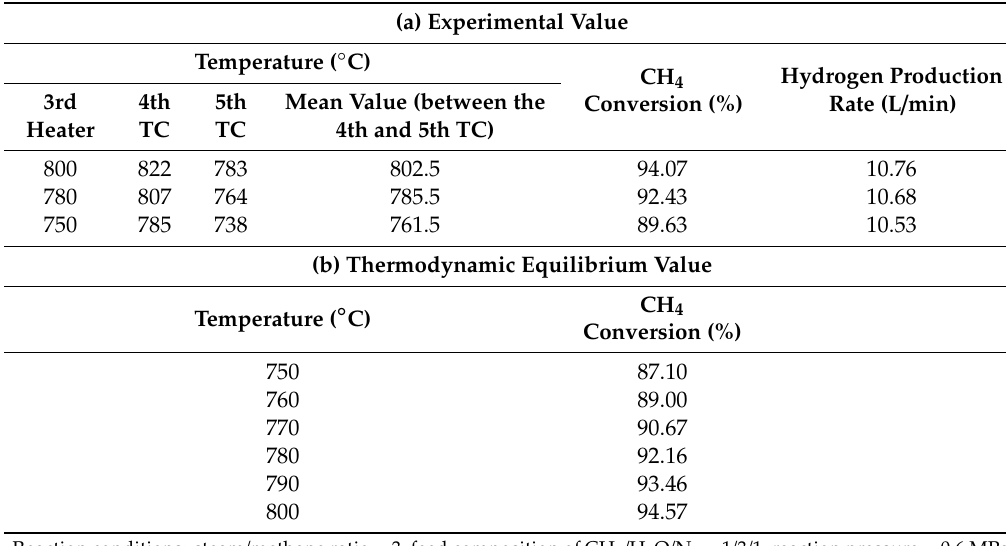
Table 1. Catalyst bed temperature gradient and CH 4 conversion at various third heater temperatures.